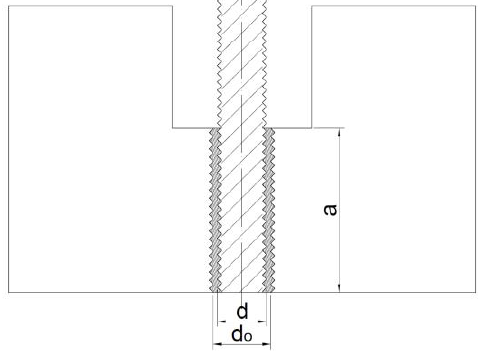
Figure 4. Enlarged section of an adhesive layer in steel test base specimen.